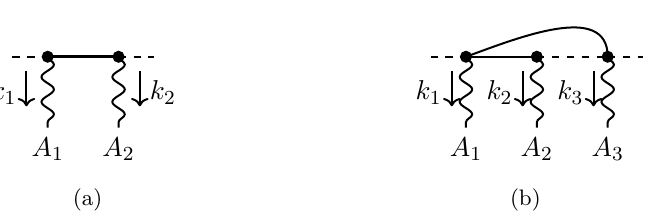
Figure 2. Worldline diagrams required for the calculation of 2-point (a) and 3-point (b) currents. The dashed lines are drawn only for illustration and represent the worldline. Solid lines represent fluctuations of matter lines and later also auxiliary variables. Wavy lines represent off-shell massless particles and A its associated